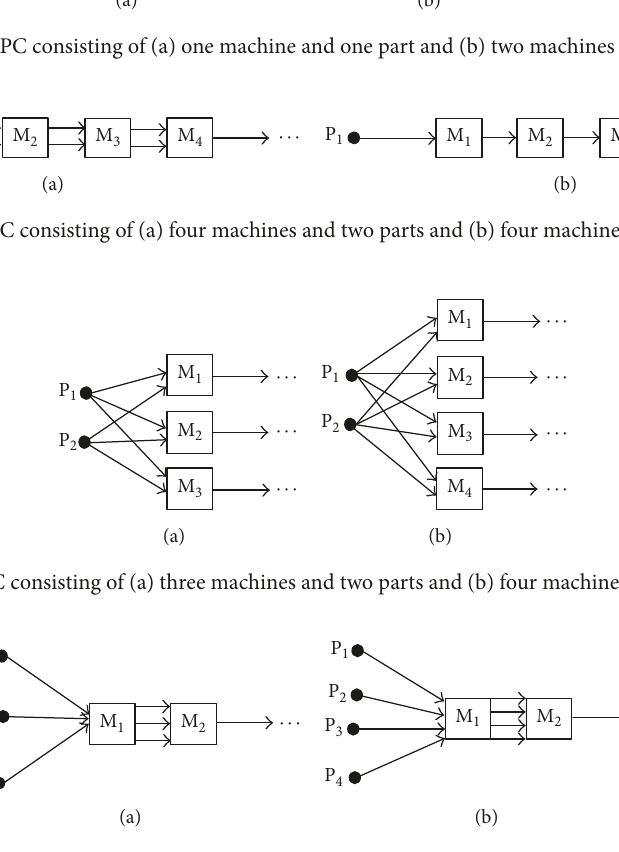
Figure 6: MPC consisting of (a) two machines and three parts and (b) two machines and four parts.